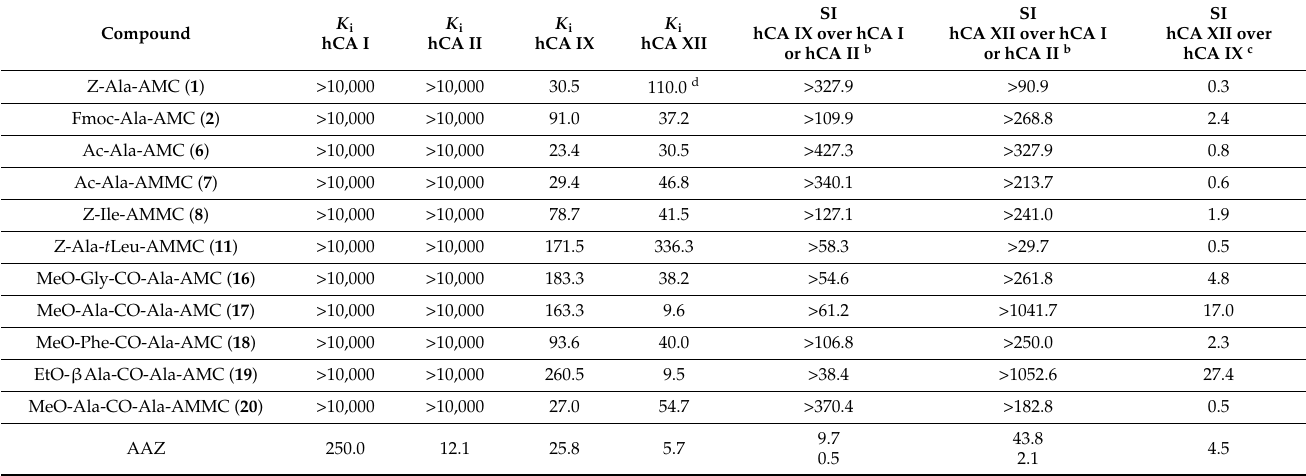
Table 1. Inhibitory activities, reported as K i (nM) values a , of amino acyl-(compounds 1 , 2 , 6 – 8 ) and ( pseudo )-dipeptidyl coumarins ( 11 , 16 – 20 ) towards hCA I, hCA II, hCA IX, and hCA XII, and corresponding selectivities among the selected hCA